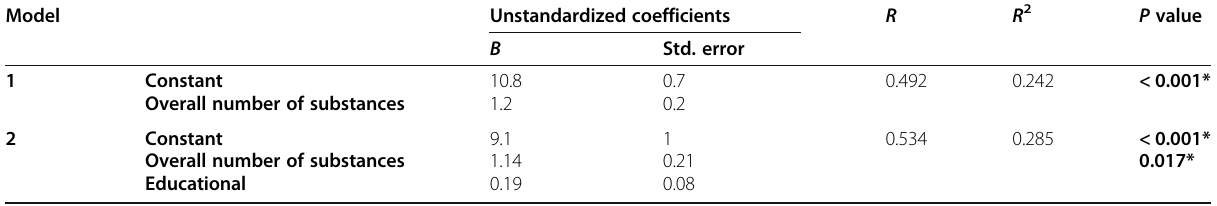
Table 7 Multiple stepwise regression analysis to detect predictors affecting Addiction Intensity Scale (AIS) scoring